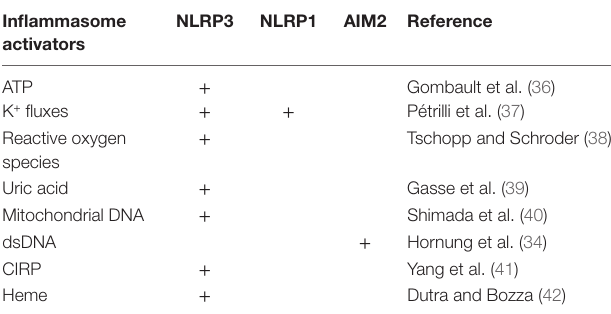
TAbLe 1 | Inflammasome activators and activated inflammasomes in